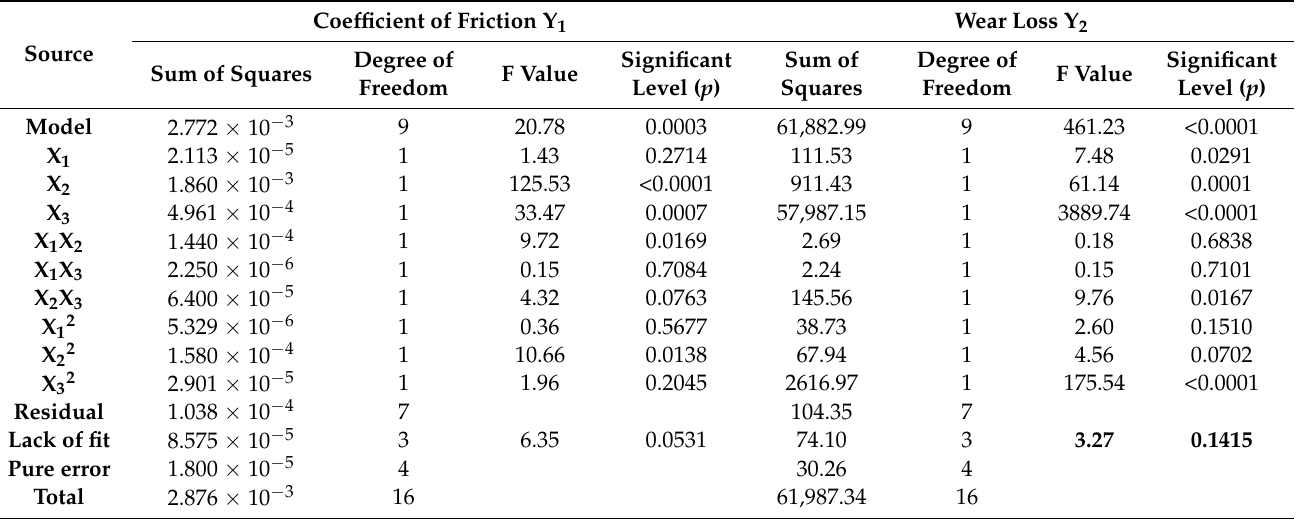
Table 3. Variance analysis of regression equation for peanut impact-friction multi-factor